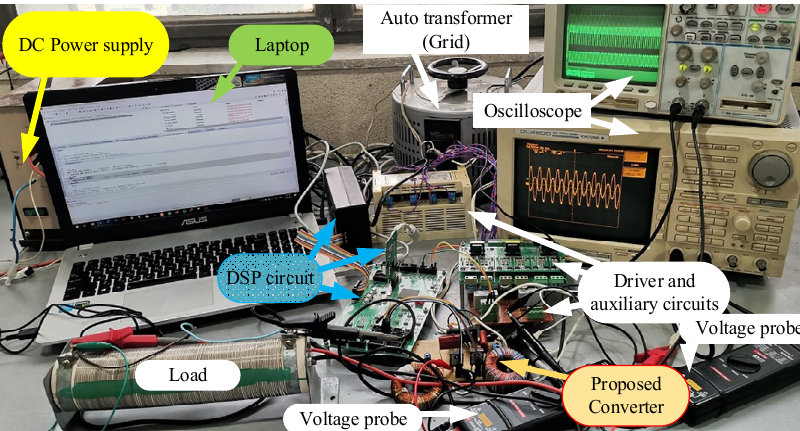
Figure 16. Simulation results of the proposed DVR at 25% voltage swell compensation: ( a ) line voltage, ( b ) output voltage of the converter, ( c ) load voltage.